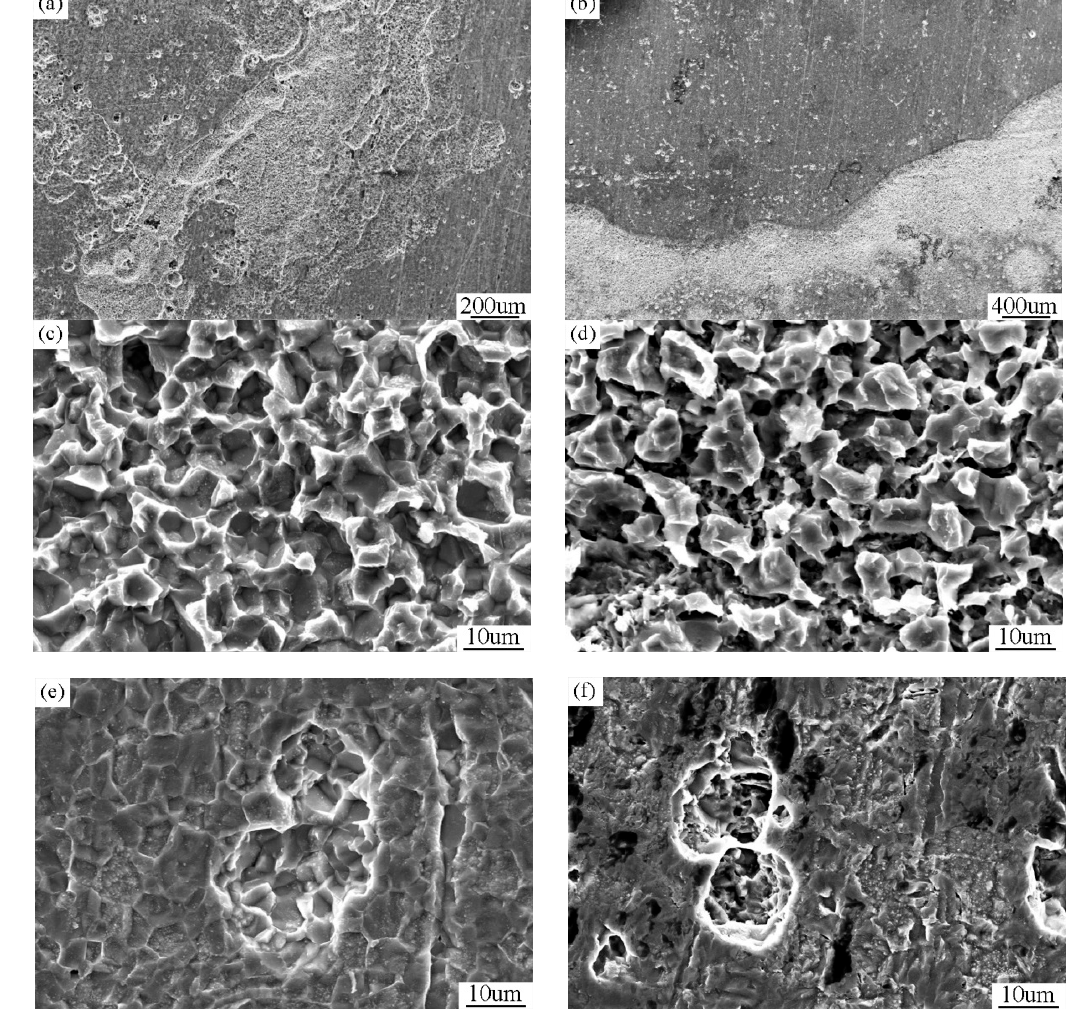
Figure 8. The corrosion morphologies of samples with corrosion product removed ( a , c , e )—bimodal ferrite steel; ( b , d , f )—dual-phase steel.